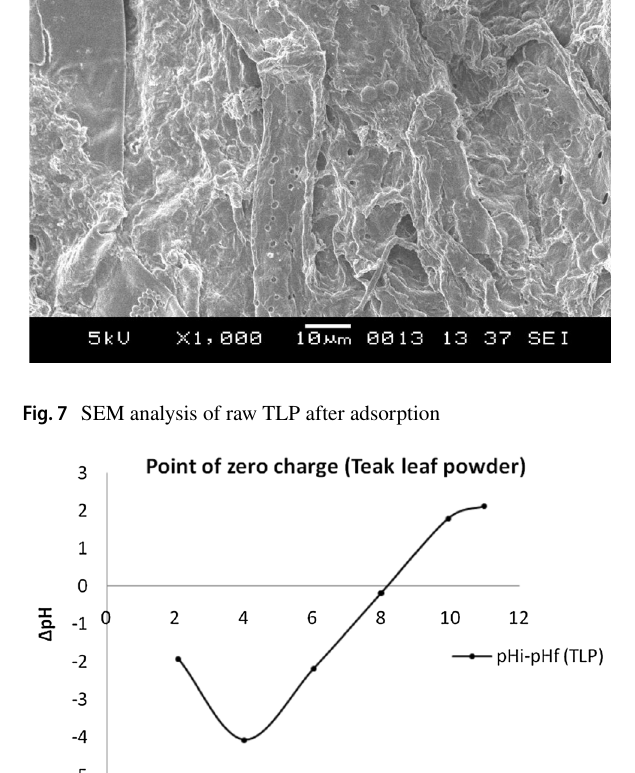
Fig. 8 Point of zero charge ( P zpc ) of activated teak leaf powder (TLP). *Adsorbent dose—0.05 g, agitation time—150 min, tempera- ture—30 °C, volume—100 ml Fig. 9 Effect of pH on CR dye removal. *Adsorbent dose—150 mg, dye concentration—20 ppm, agitation time—150 min., tempera- ture—30 °C, volume—100 ml